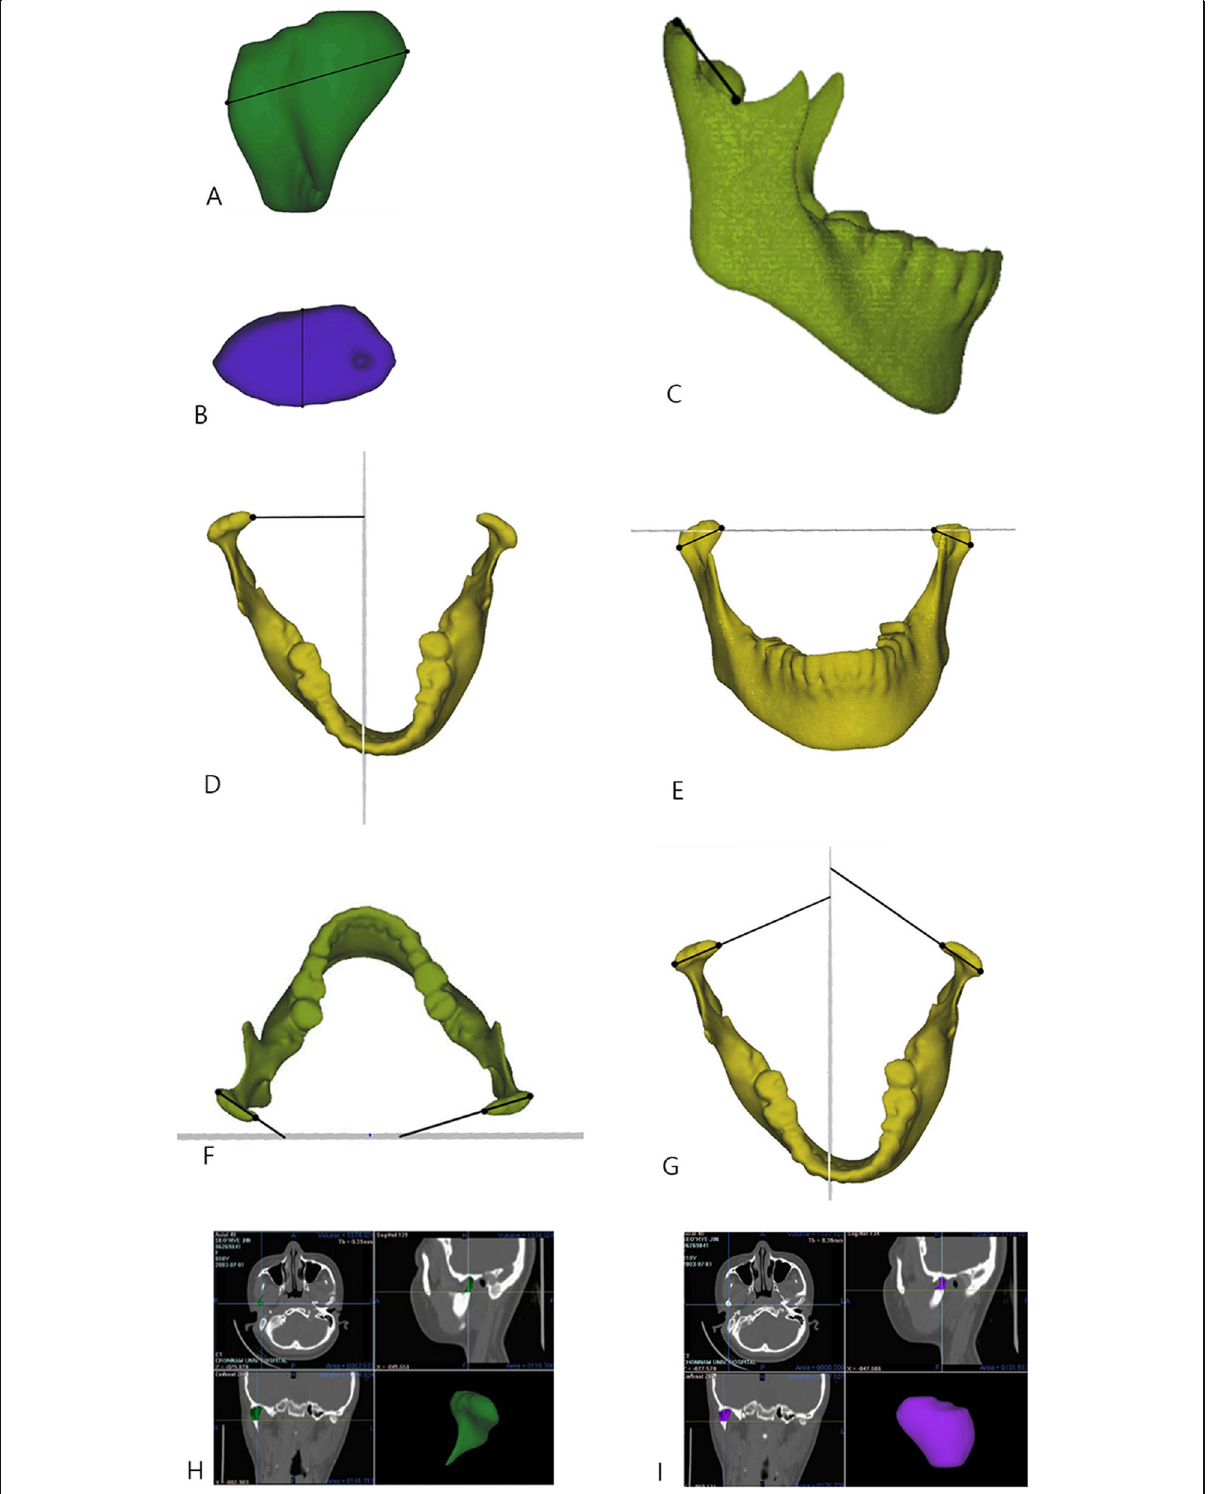
Fig. 2 The measurements of the mandibular condyle. a Mediolateral dimension of the condyle. b Anteroposterior dimension of the condyle. c Neck length. d Mediolateral condylar position. e Condylar angle to the Frankfort horizontal plane. f Condylar angle to the anteroposterior reference plane. g Condylar angle to the midsagittal reference plane. h Neck volume. i Head volume (reproduced with permission